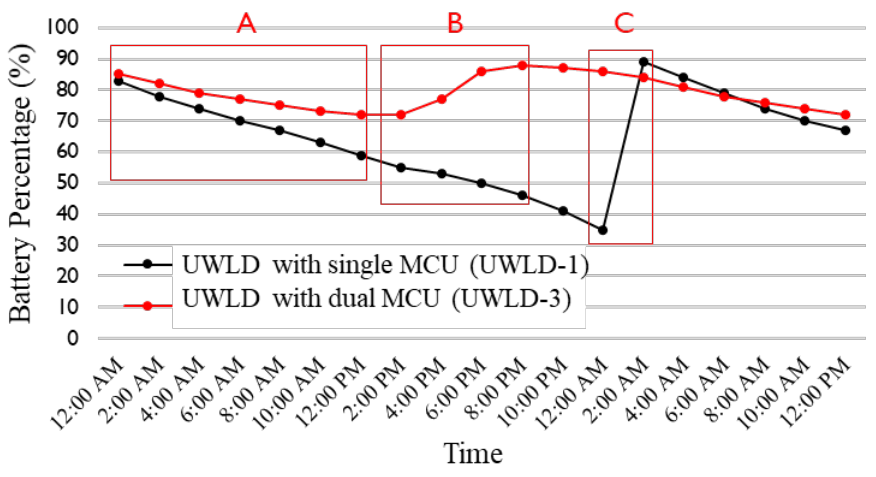
Figure 11. Thirty-six h monitoring of battery percentage record of the UWLD system with the single-MCU system (UWLD-1) in black and dual-MCU system (UWLD-3) in red under similar sunlight conditions. A, B, and C regions indicate battery consumption at the nighttime and daytime and battery replacement time (battery replacement is for only UWLD-1 unit). The result implies the dual-MCU system improves the energy efficiency of the UWLD unit without changing the battery for longer operation period.